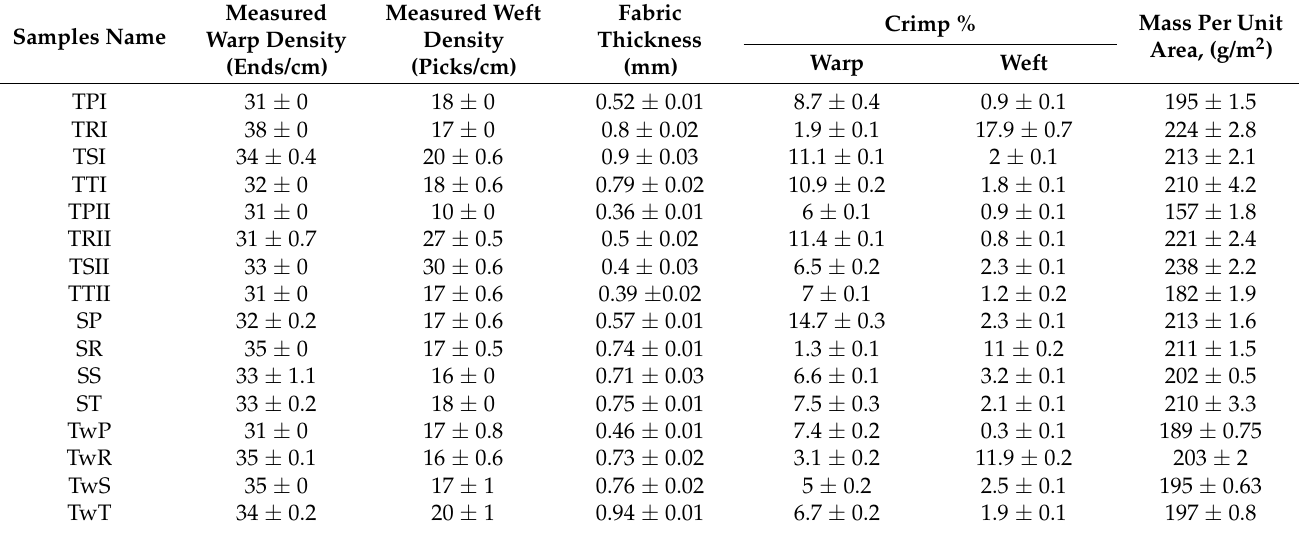
Table 3. Measured construction parameters for 16 woven fabric